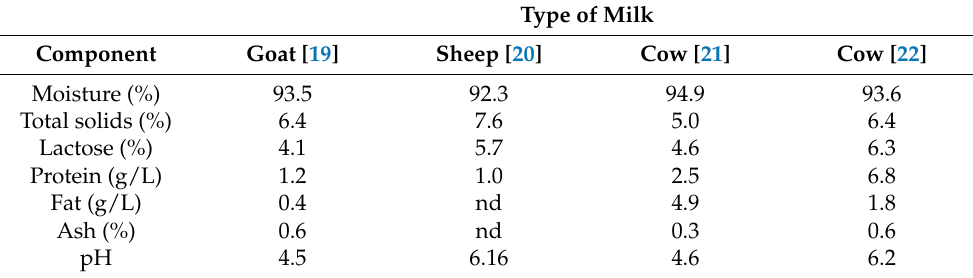
Table 1. Chemical composition of cheese whey from different milk sources as well as acid and sweet whey.